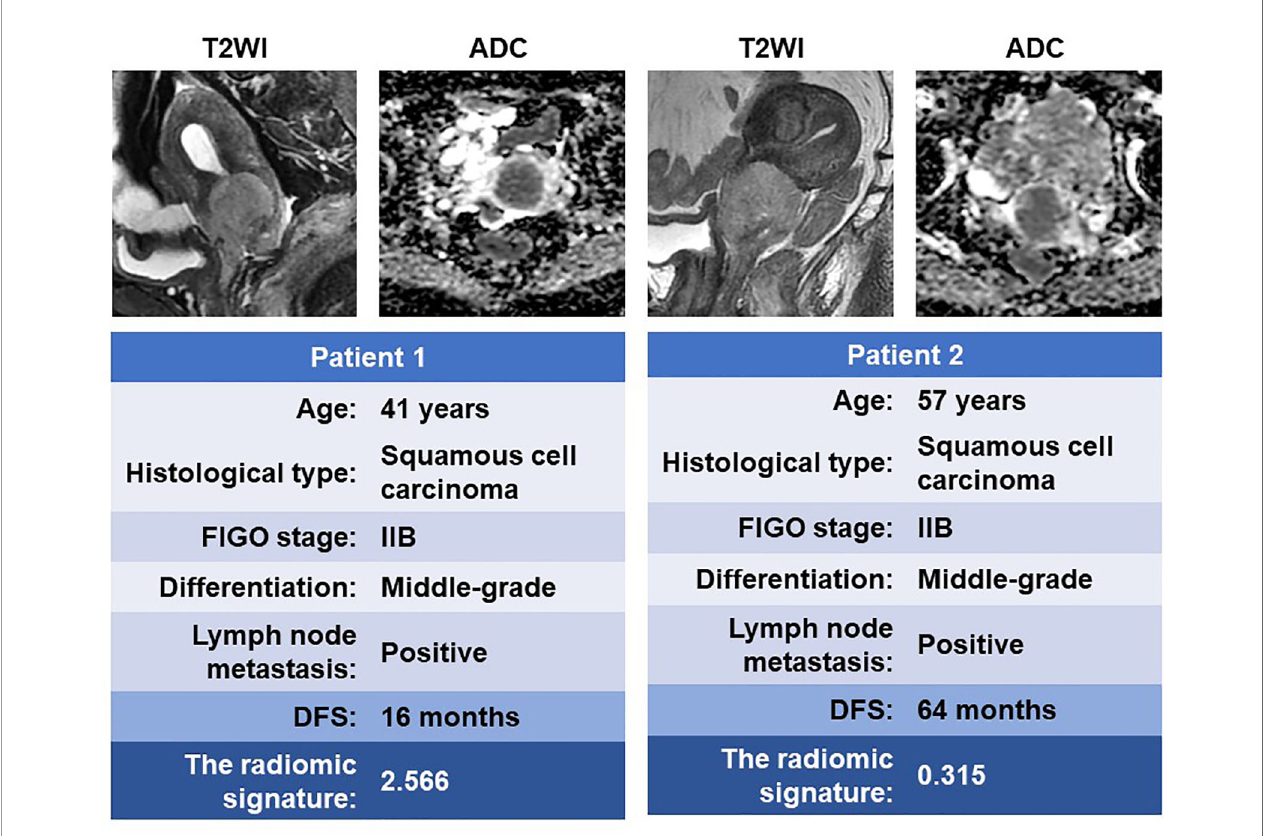
FIGURE 3 | MR images of two patients with similar clinicopathological features but signi fi cantly different DFS time. DFS, disease-free